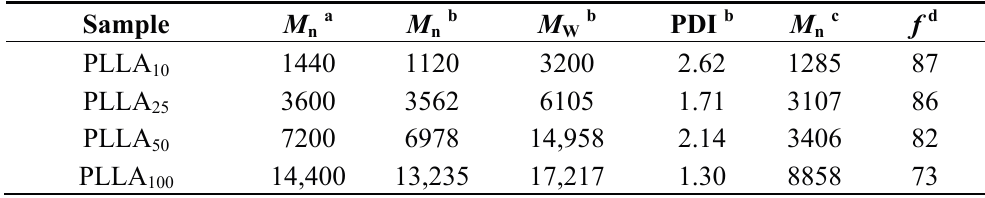
Table 1. Molecular weight characterization and degree of functionalization of PLLA-NHBoc homopolylactides. a M b M b PDI b M c f d Sample M n n W n PLLA 1440 1120 3200 2.62 1285 87 10 PLLA 3600 3562 6105 1.71 3107 86 25 PLLA 7200 6978 14,958 2.14 3406 82 50 PLLA 14,400 13,235 17,217 1.30 8858 100